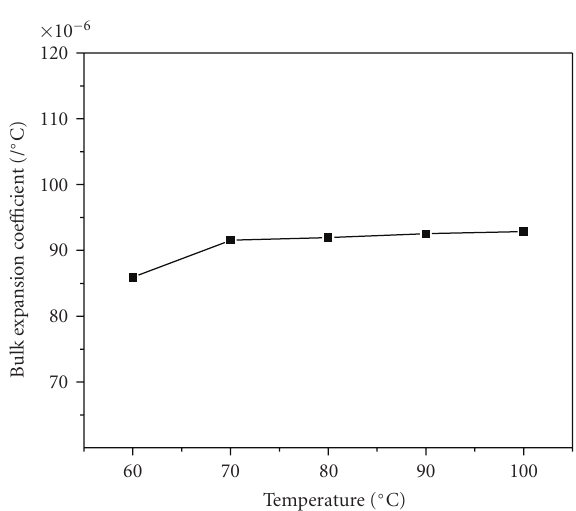
Figure 22: Bulk expansion coe ffi cient versus temperature.